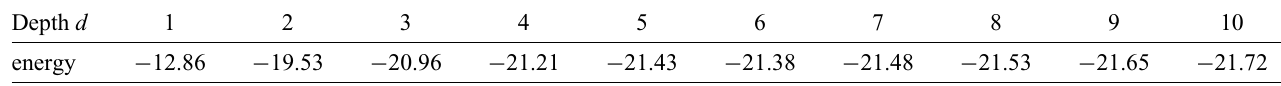
TABLE I. Convergence of the energy for 12-qubit kagome lattice with increasing ansatz depth. Depth d energy